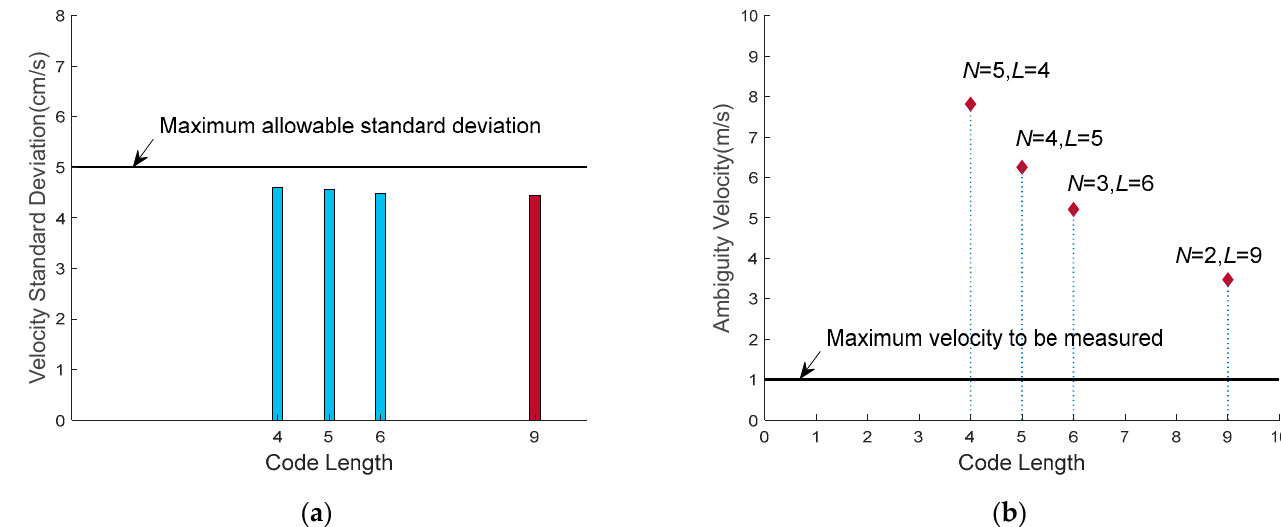
Figure 11. Velocity standard deviation and velocity estimation range of the four waveforms all meet the constraint conditions: ( a ) velocity standard deviation achieved by four waveforms; ( b ) velocity estimation range achieved by four waveforms.